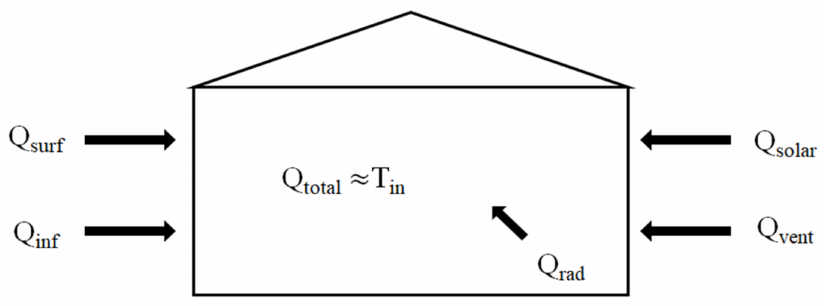
Figure 8. Energy balance of hybrid heating system in